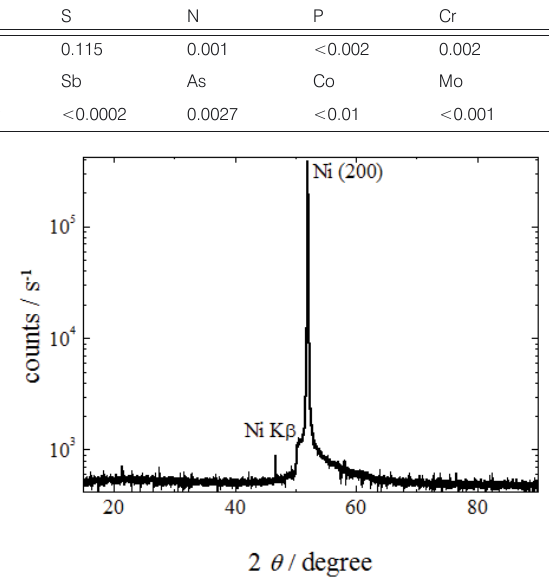
Figure 2. XRD spectrum of a Ni tape annealed at 1000°C for 120 min in flowing Ar + 6.5% v/v H 2